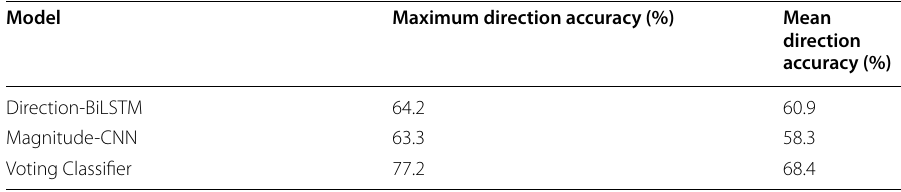
Table 5 Accuracies of Direction-BiLSTM, Magnitude-CNN and Voting Classifier